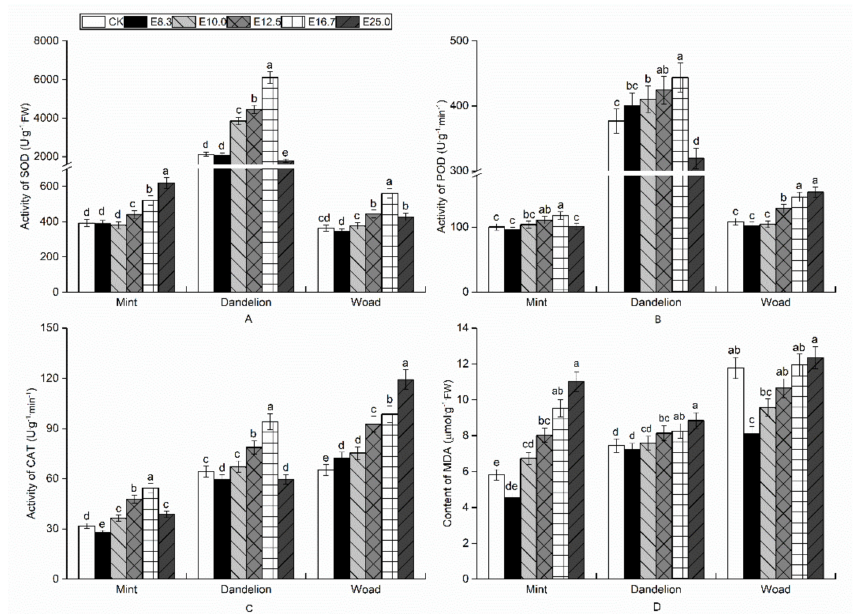
Figure 5. Effect of leaf aqueous extract of fig tree on ( A ) SOD, ( B ) POD, ( C ) CAT and ( D ) MDA content of three medicinal plants. Values are reported as mean ± SD, n = 3. CK, 0.0 g/L; E8.3, 8.3 g/L; E10.0, 10.0 g/L; E12.5, 12.5 g/L; E16.7, 16.7 g/L; E25.0, 25.0 g/L. Lowercase letters represent significant differences in each treatment group ( p <